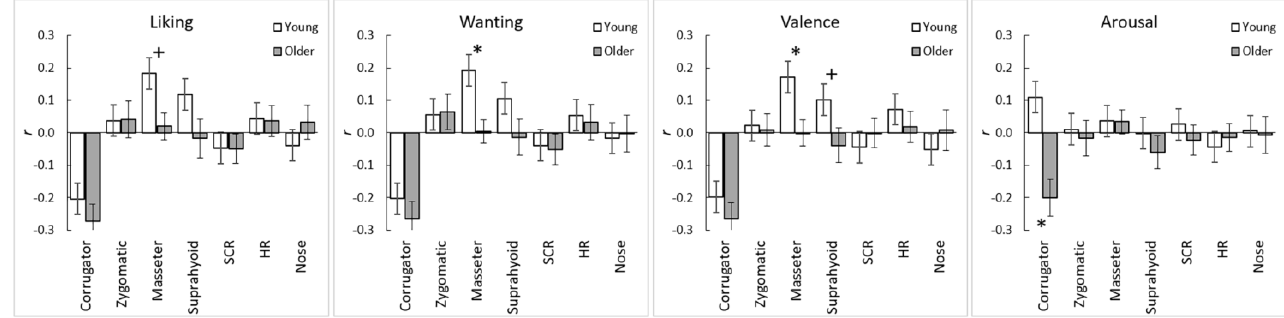
Figure 1. Mean (with SE ) of intra-individual correlation coefficients between subjective ratings and the physiological measurements across the stimuli in the young and older adult groups. Asterisks indicate significant group differences (*, p < 0.05; +, p < 0.10). Corrugator = corrugator supercilia; Zygomatic = zygomatic major; SCR = skin conductance response; HR = heart rate; Nose = nose-tip temperature. Table 1. Results of one-sample t -tests (vs. 0; two-tailed) for subjective – physiological coherence in young and older groups.